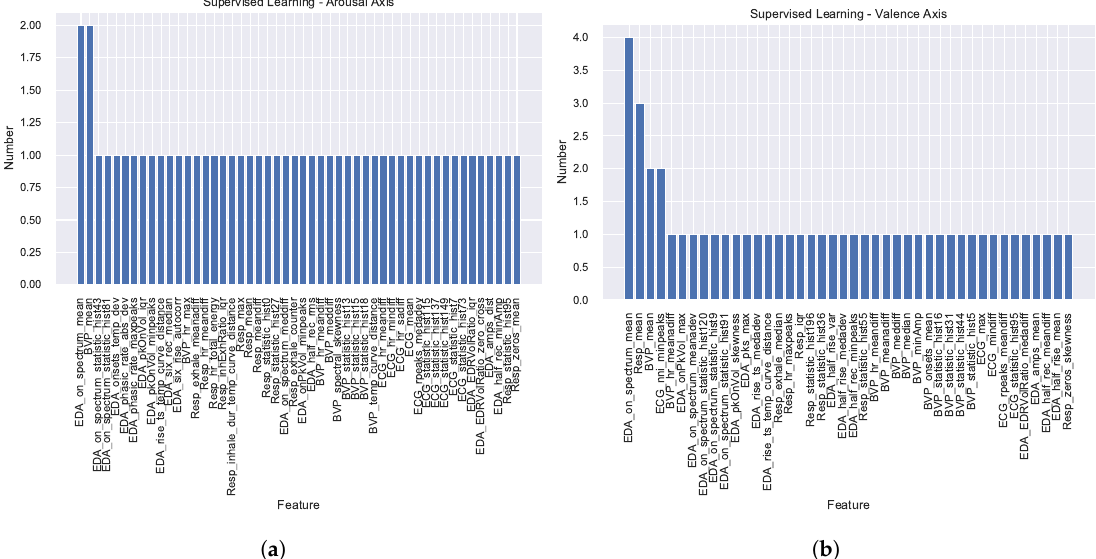
Figure A1. Histogram combining the features used in the SL (Supervised Learning) methodologies in all the datasets for the Arousal and Valence axis in ( a , b ), respectively. For information regarding the features the authors refer the reader to